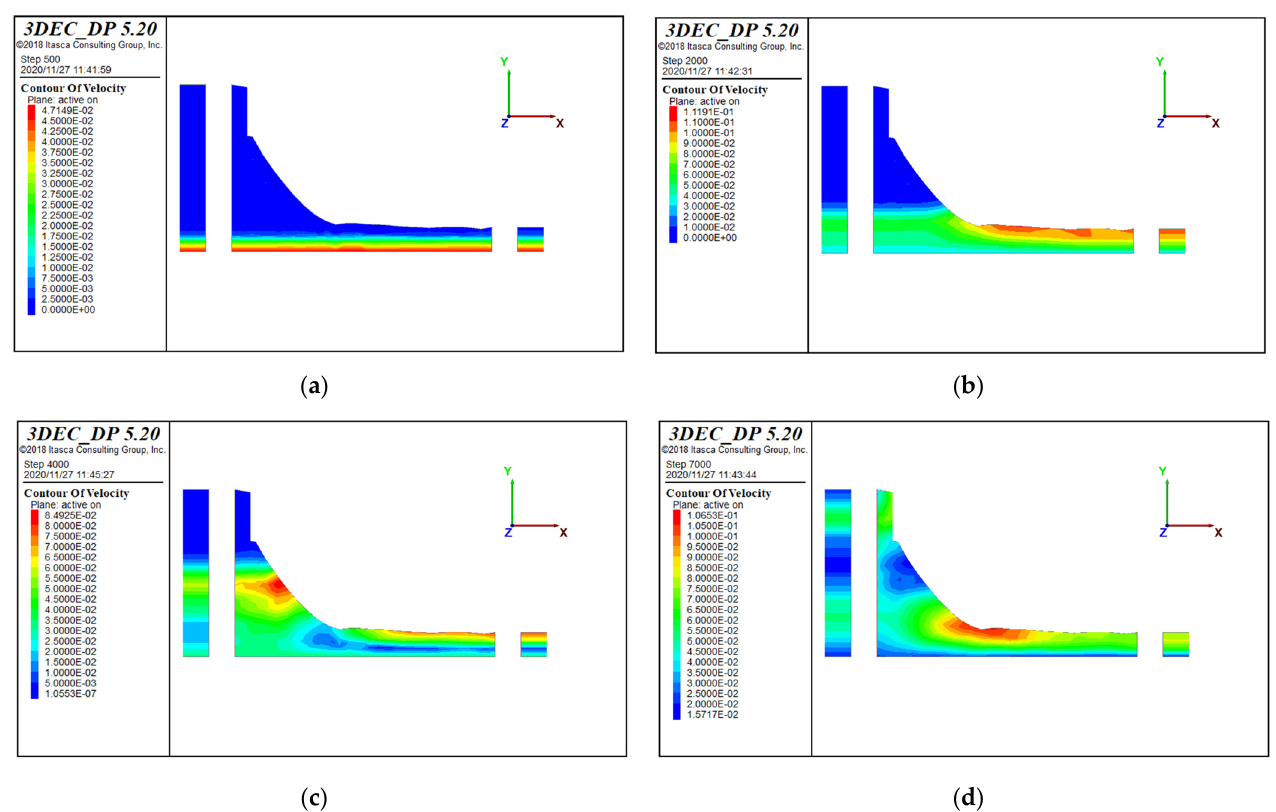
Figure 11. Dynamic response of the high ‐ steep rock slide (under EW seismic wave loading): ( a ) 500 steps; ( b ) 2000 steps; ( c ) 4000 steps; and ( d ) 7000 steps.